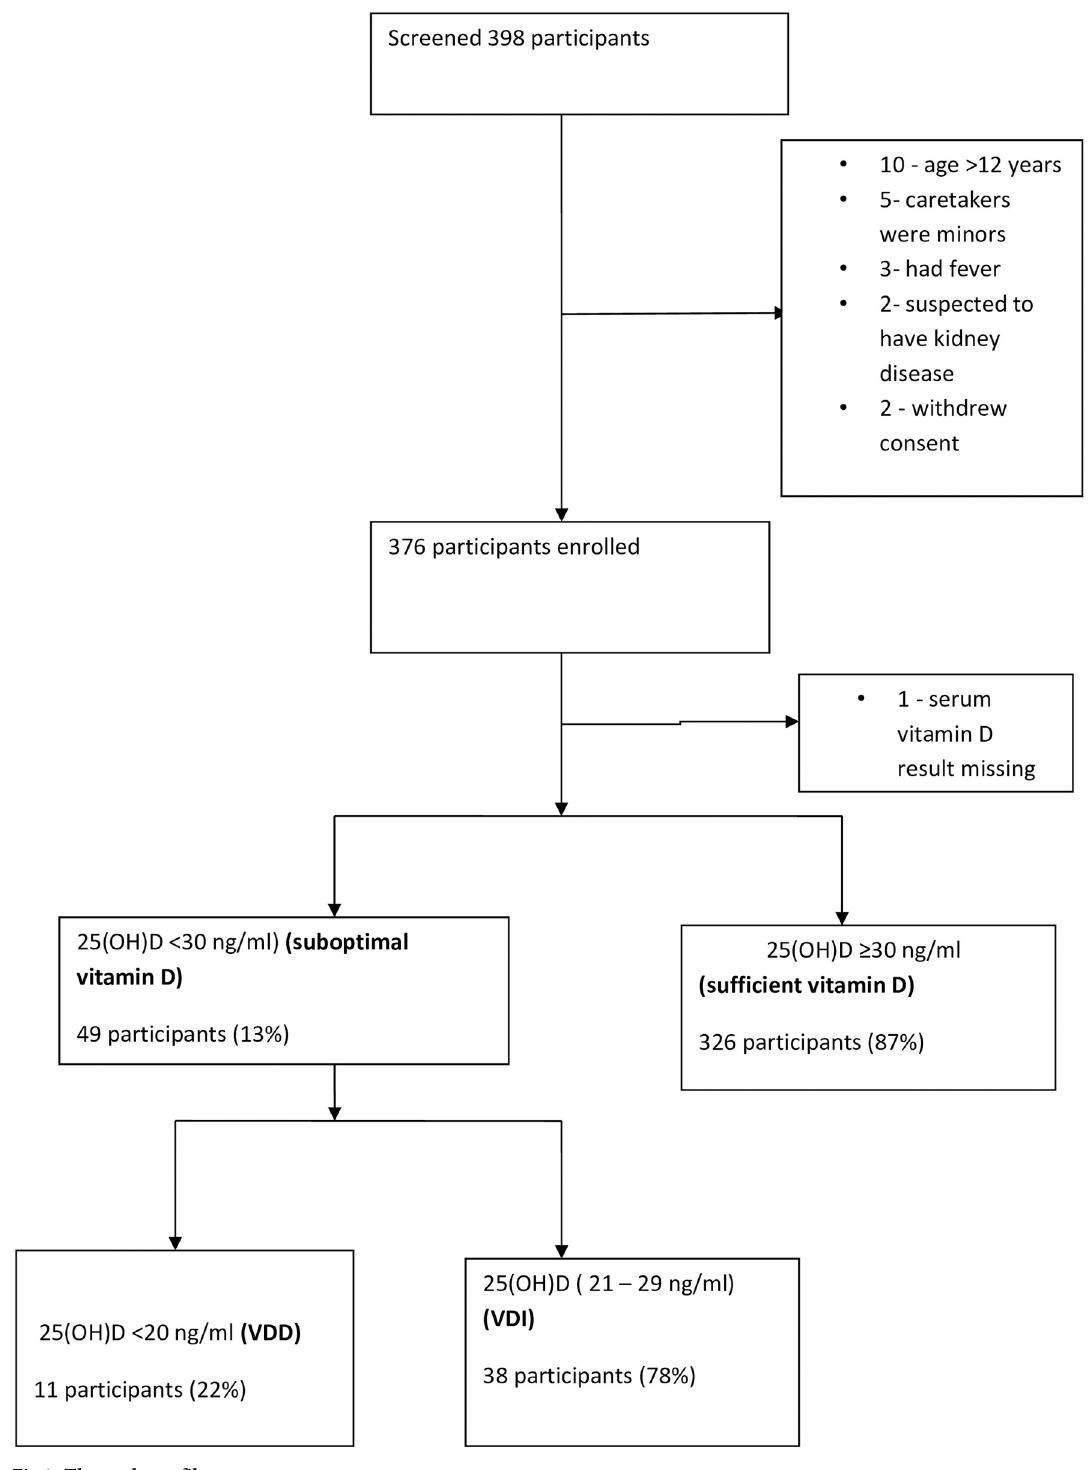
Fig 1. The study